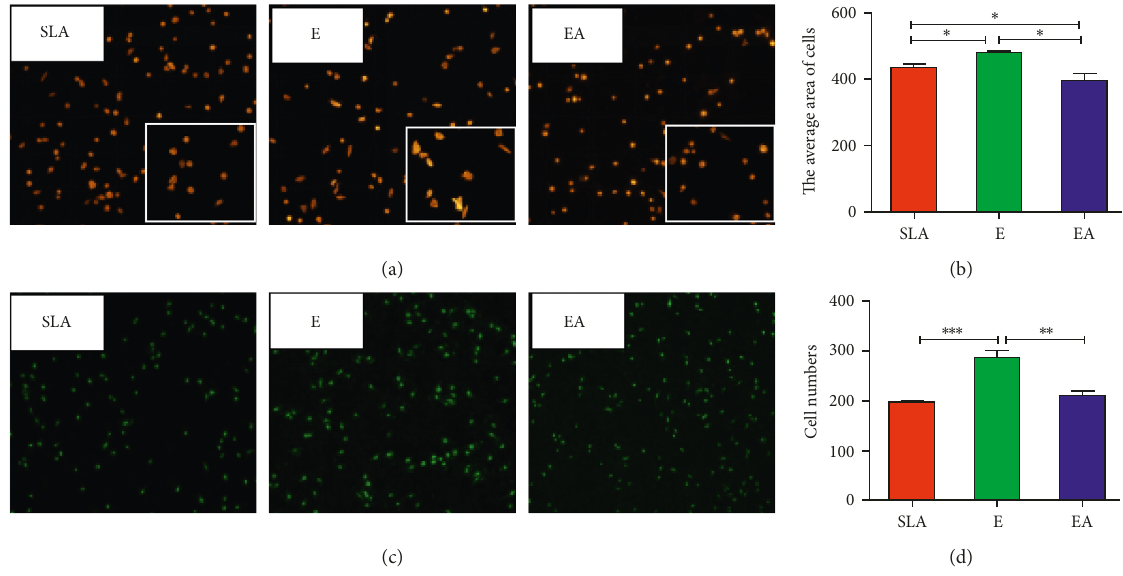
Figure 5: Attached cell average areas (a, b) and numbers (c, d) of MG63 cells cultured on each group of surfaces for 4